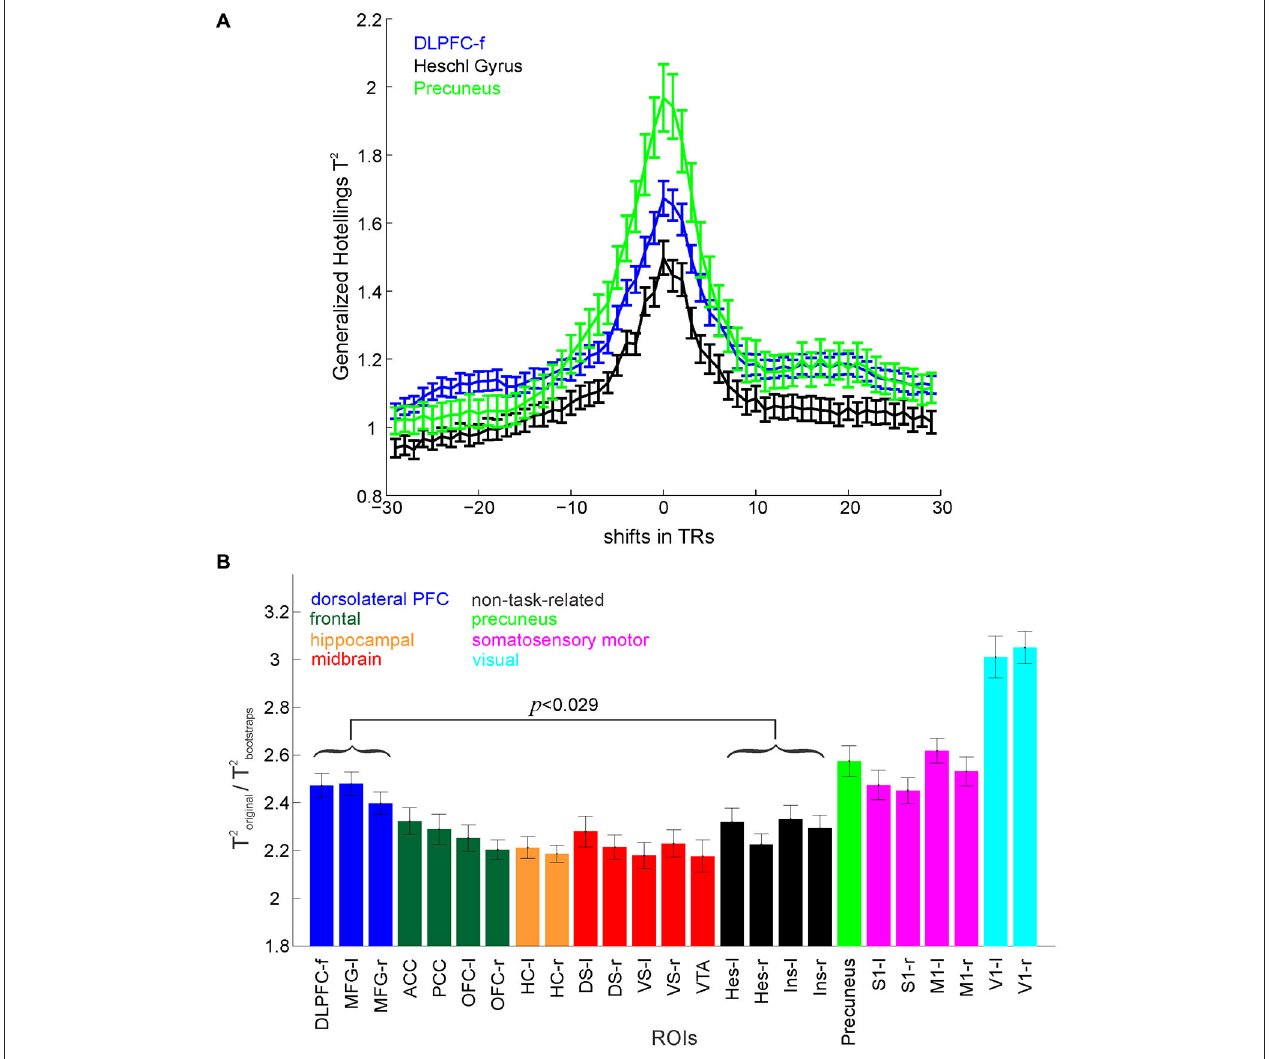
FIGURE 2 | Multivariate test statistics. (A) Hotelling’s Generalized T 2 computed for a set of positive (lags) and negative (leads) shifts of behavioral labels with respect to the time series. The maximum test statistic occurs at zero lag after time-series deconvolution. (B) Hotelling’s Generalized T 2 normalized by the corresponding bootstraps for different ROIs. The DLPFC (represented by 3 masks, MFG left and right, and DLPFC-f) shows significantly higher overall separation of the task stages in comparison to non-task-related areas ( p -value Bonferroni corrected for multiple comparisons). Error bars = SEM across